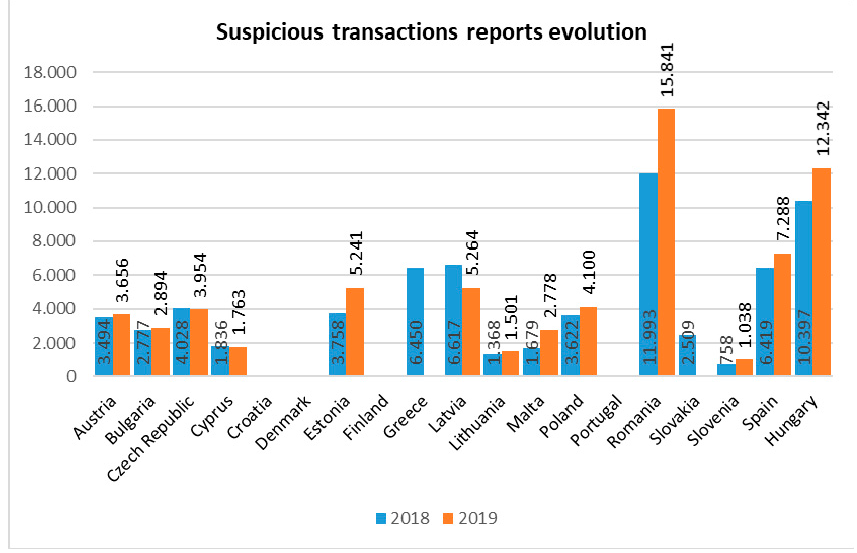
Figure 1. Number of suspicious transactions evolution in the European Member States between 2018–2019. Source: own processing.